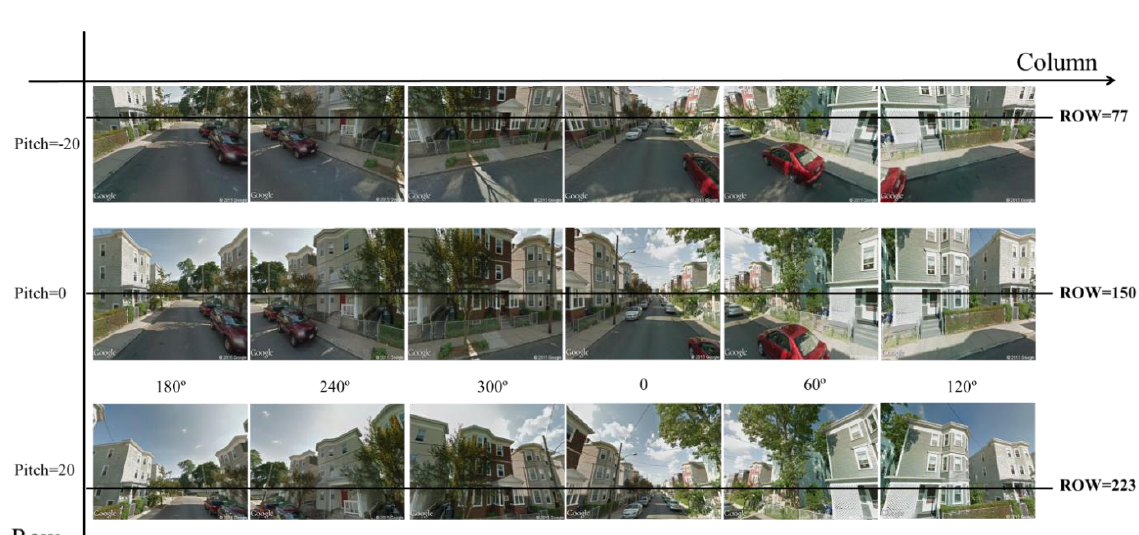
Figure 5. Static Google Street View images of one site (42.317948°N, 71.054739°W) in Boston at different directions and pitch angles. When the pitch angle is 0, the middle line (Row 150) is the horizon (2.5 m